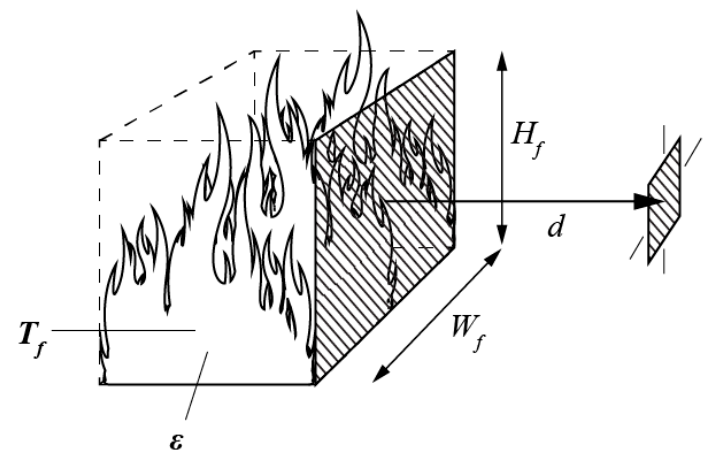
Figure 1. Schematic representation of the radiation model. Emissivity ( ε ) of the flame can vary greatly and is difficult to calculate due to a complexity of fire process and multiple factors affecting it. These factors include fuel type and its moisture content, environmental conditions and the type of combustion. Moreover, daily fluctuations of weather conditions, such as temperature and humidity, directly affect the fuel moisture content. Thus, in real conditions during the burning process the parameters of flame do not remain constant. Emissivity also depends on flame dimensions. It was experimentally found that it increases with increasing thickness, or diameter of flames [21–23] and may reach its maximum possible value of 1. Bushfire models assume that flames are uniform black bodies and have an emissivity of 1 (maximum value of this parameter), which is an assumption for large wildland fires, namely in condition where the flames are more than 3 m in depth (flame thickness) [18].